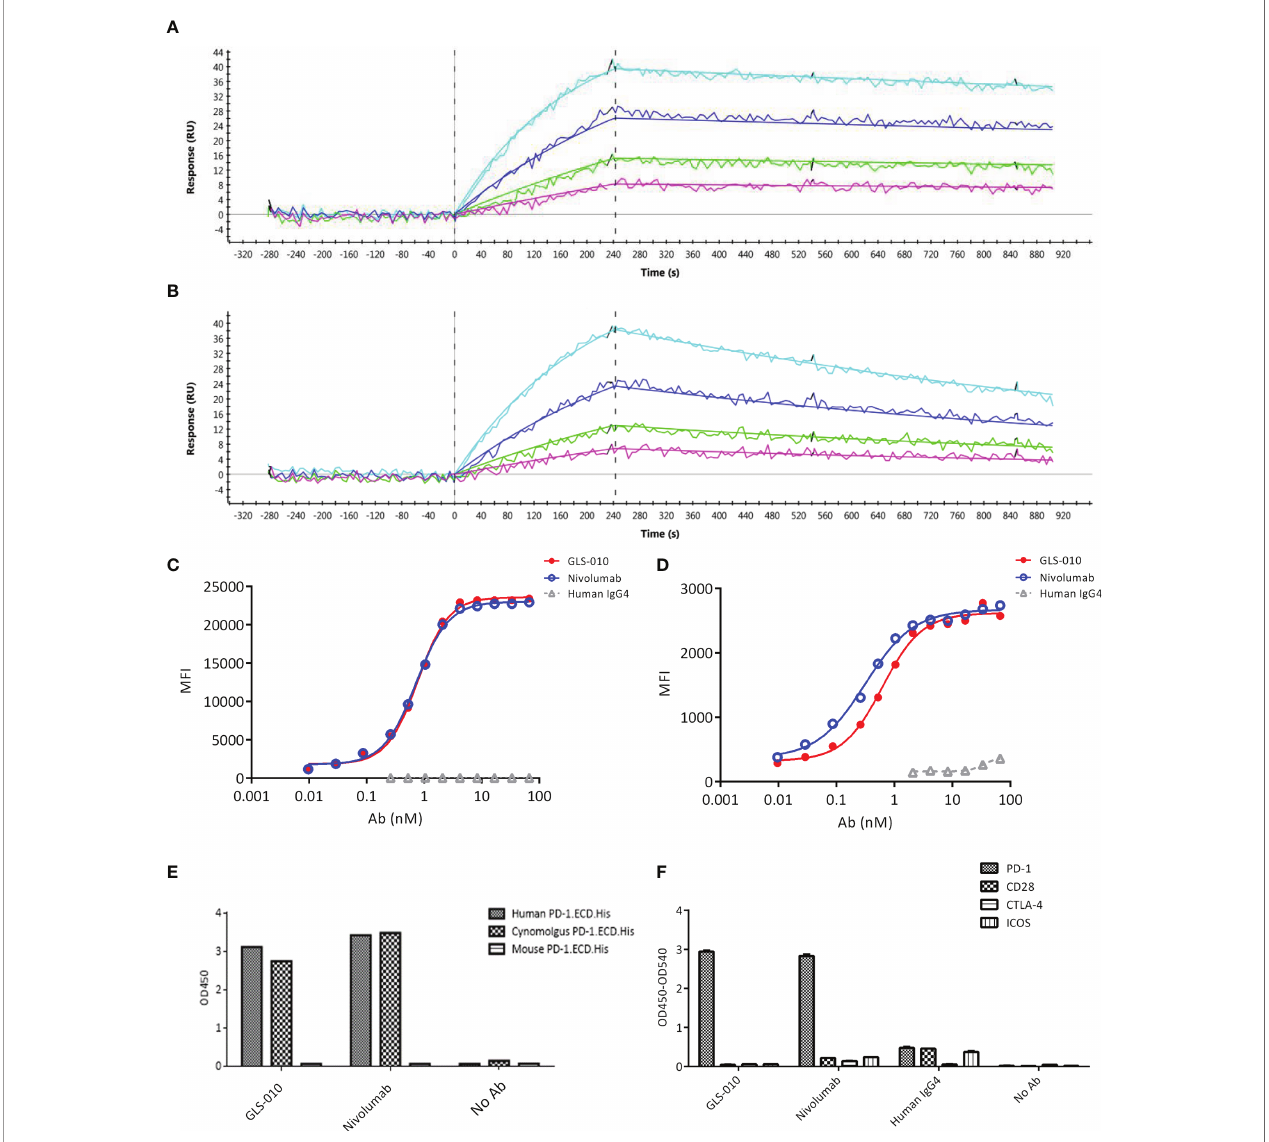
FIGURE 1 | Af fi nity and binding speci fi city of GLS-010 to PD-1 by surface plasmon resonance (SPR) and cell-based assays. Association and dissociation of GLS- 010 (A) and nivolumab (B) to hPD-1 by SPR. The concentration, from low to high, was 1.25, 2.5, 5, and 10 nM. The binding af fi nity of GLS-010 and nivolumab to CHO cell (C) and primary CD4 + T cell (D) expressing hPD-1. (E) Af fi nity of GLS-010 and nivolumab to human-, cynomolgus monkeys-, and mouse-derived PD-1 by ELISA. (F) GLS-010 and nivolumab bind to hPD-1 but not to other CD28 homologous proteins, including CD28, CTLA-4, and